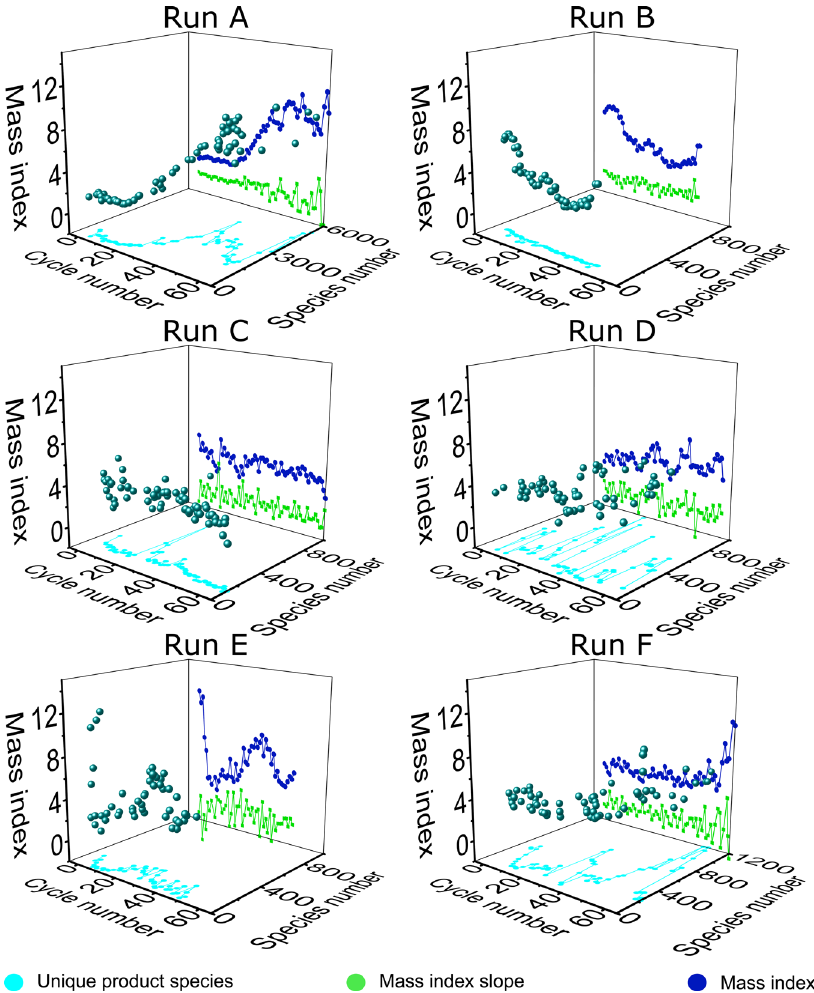
Fig. 4 Selected experiments, which reached 65 cycles or more. The light-blue line represents the number of unique product species versus the number of cycles, while the dark-blue line represents the calculated Mass Index for each respective cycle. The green line shows the corresponding slope of the Mass Index values. The spherical data points map these in 3D. Run A, B, C, and D had a cycle time of 6 h, while E and F had 3 h per